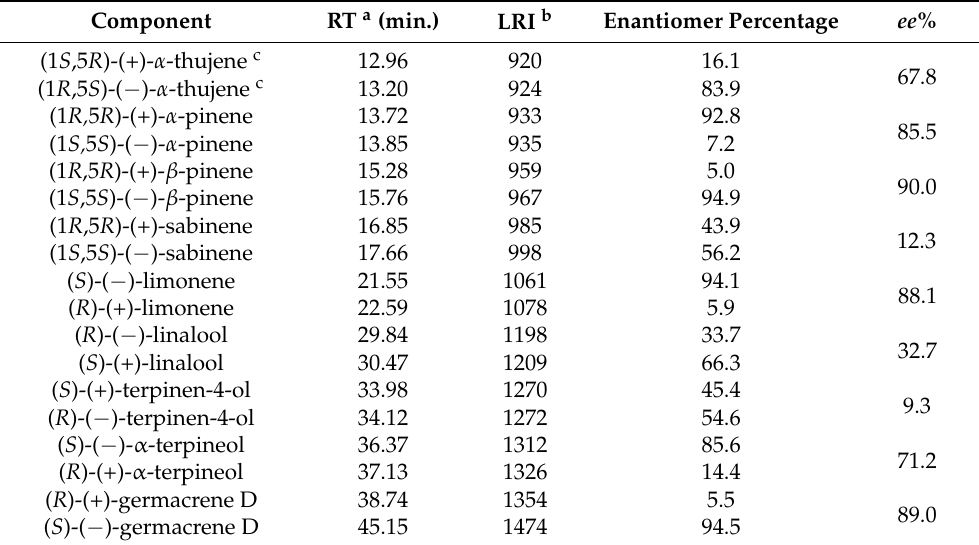
Table 2. Enantioselective analysis of some chiral constituents of C. taxifolium EO on diethyl- tert - butyldimethylsilyl- β -cyclodextrin column.